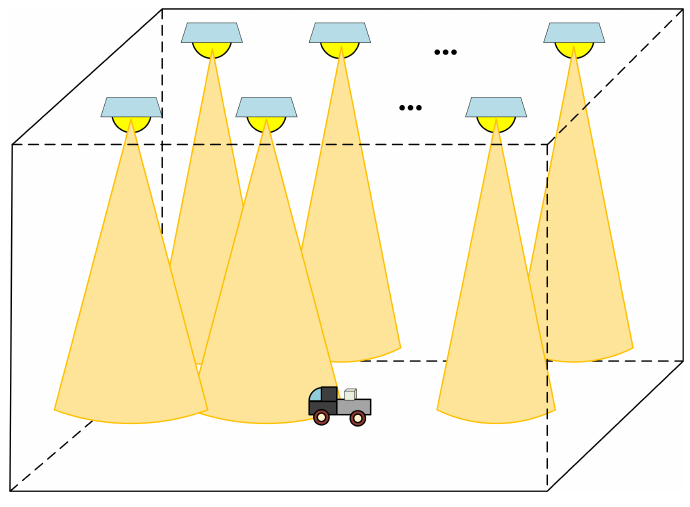
Figure 1. System configuration.